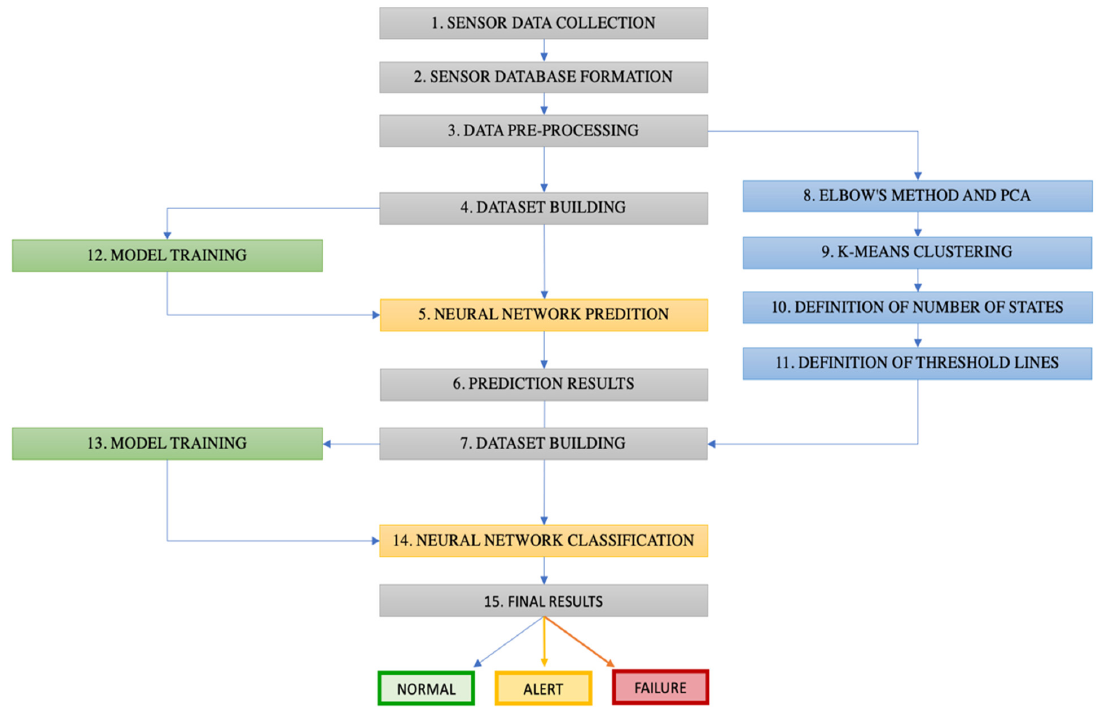
Figure 6. Methodology used to classify press condition.